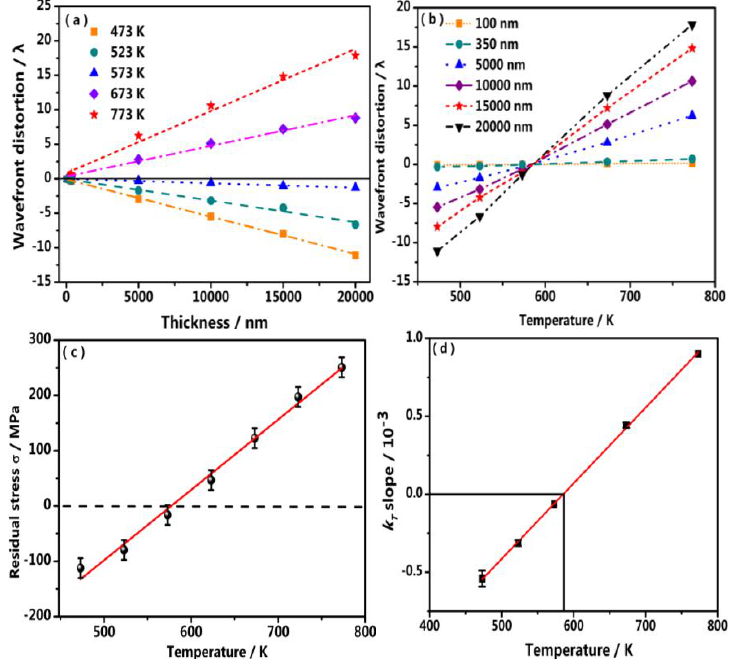
Figure 3. ( a ) The relationship curve between RWD and thickness of Ta 2 O 5 film annealed at different temperatures; ( b ) the relationship between temperature and the RWD of Ta 2 O 5 films with different thicknesses; ( c ) the stress of the Ta 2 O 5 films with thicknesses of 500 nm annealed at different temperatures; annealing temperatures are set at 473 K, 523 K, 573 K, 623 K, 673 K, 723 K, and 773 K, respectively; and ( d ) the relationship between k T (slope) and annealing temperature. k T , which is related to the annealing temperature, is the slope of Equation (7) and described using Equation (8).